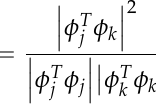
Figure 4. ( a ) Example of the time response of a hammer tap. ( b ) Accelerometer response.